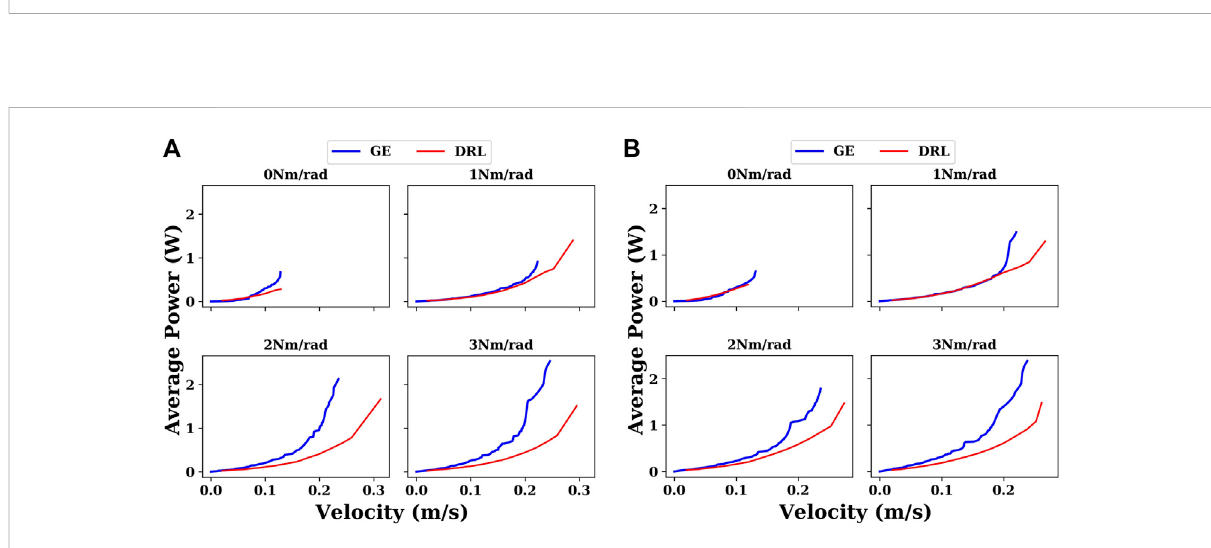
FIGURE 9 Comparison between the gait equation controller and DRL controller with different joint stiffnesses in different liquid environments. (A) In propylene (density of 514 kg/m 3 and viscosity of 0.0001 Pa · s); (B) in ethylene glycol (density of 1,097 kg/m 3 and viscosity of 0.016 Pa ·